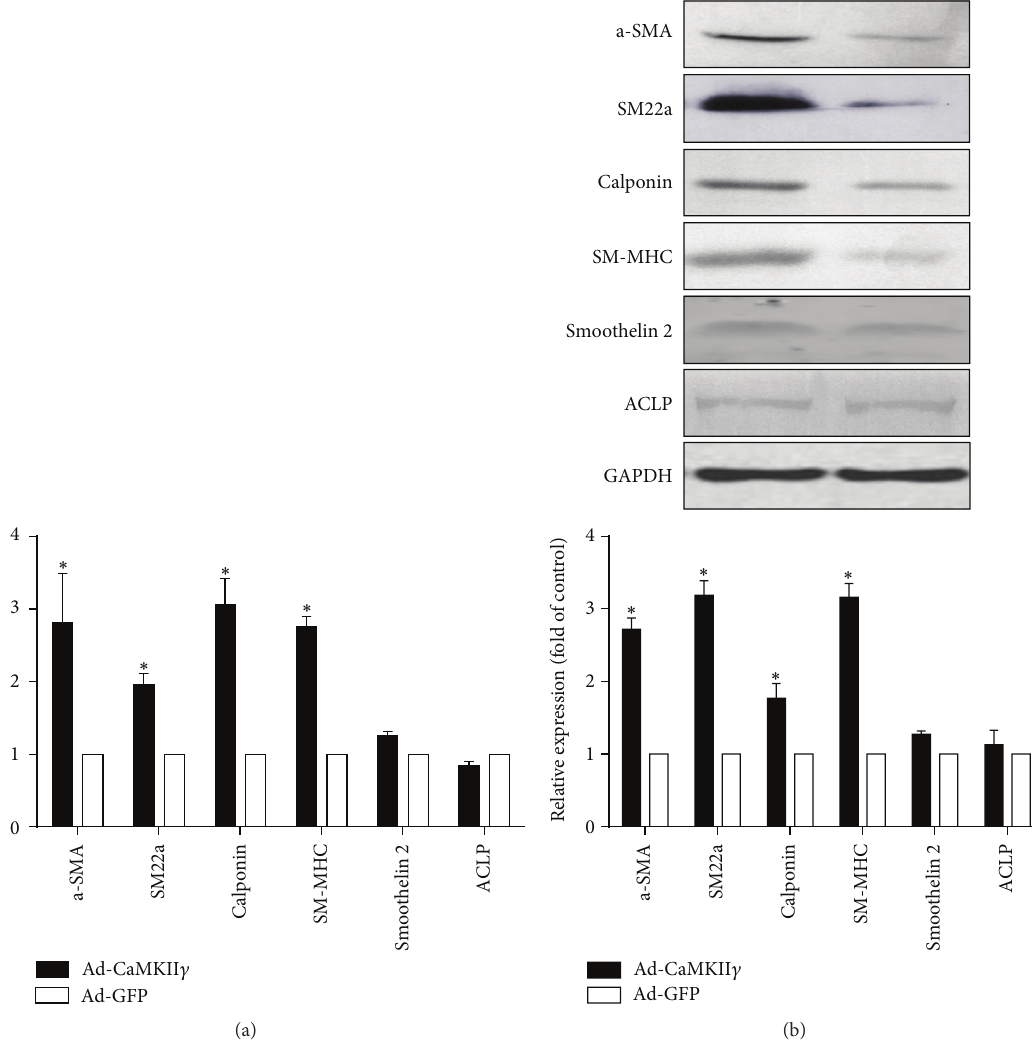
Figure 4: Transfection of CaMKII 𝛾 upregulated expression of smooth muscle contractile markers. (a) qRT-PCR analysis of smooth muscle specific markers. (b) Western blot analysis of smooth muscle contractile proteins in CaMKII 𝛾 and control group, respectively. Data represent means ± SE, 𝑛 = 3 ( ∗ 𝑃 < 0.05 versus